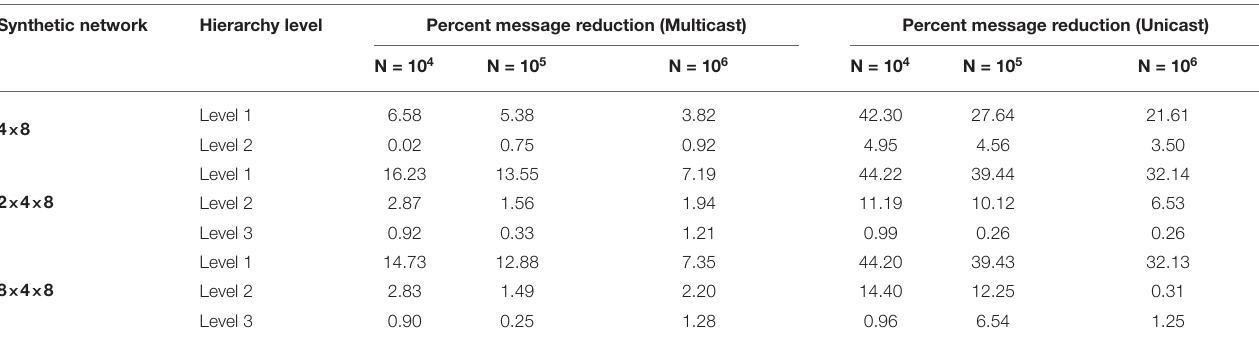
TABLE 1 | Small-world network hierarchical partitioning results (fan-out = 256). Synthetic network Hierarchy